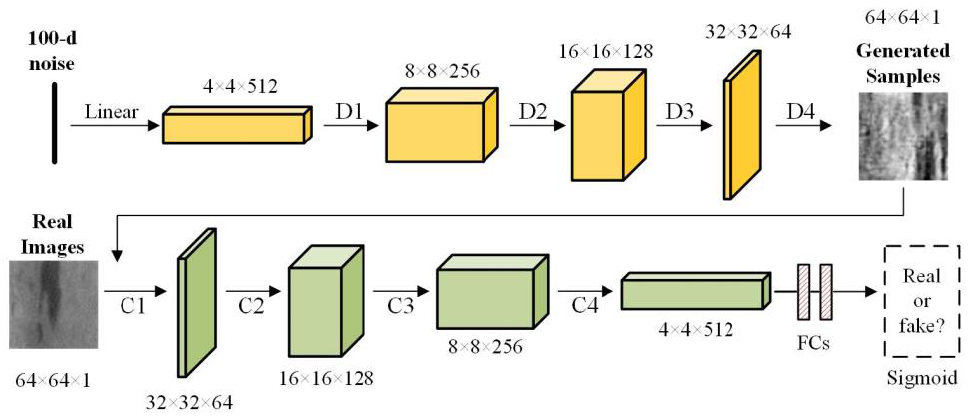
Figure 1. The architecture of the customized